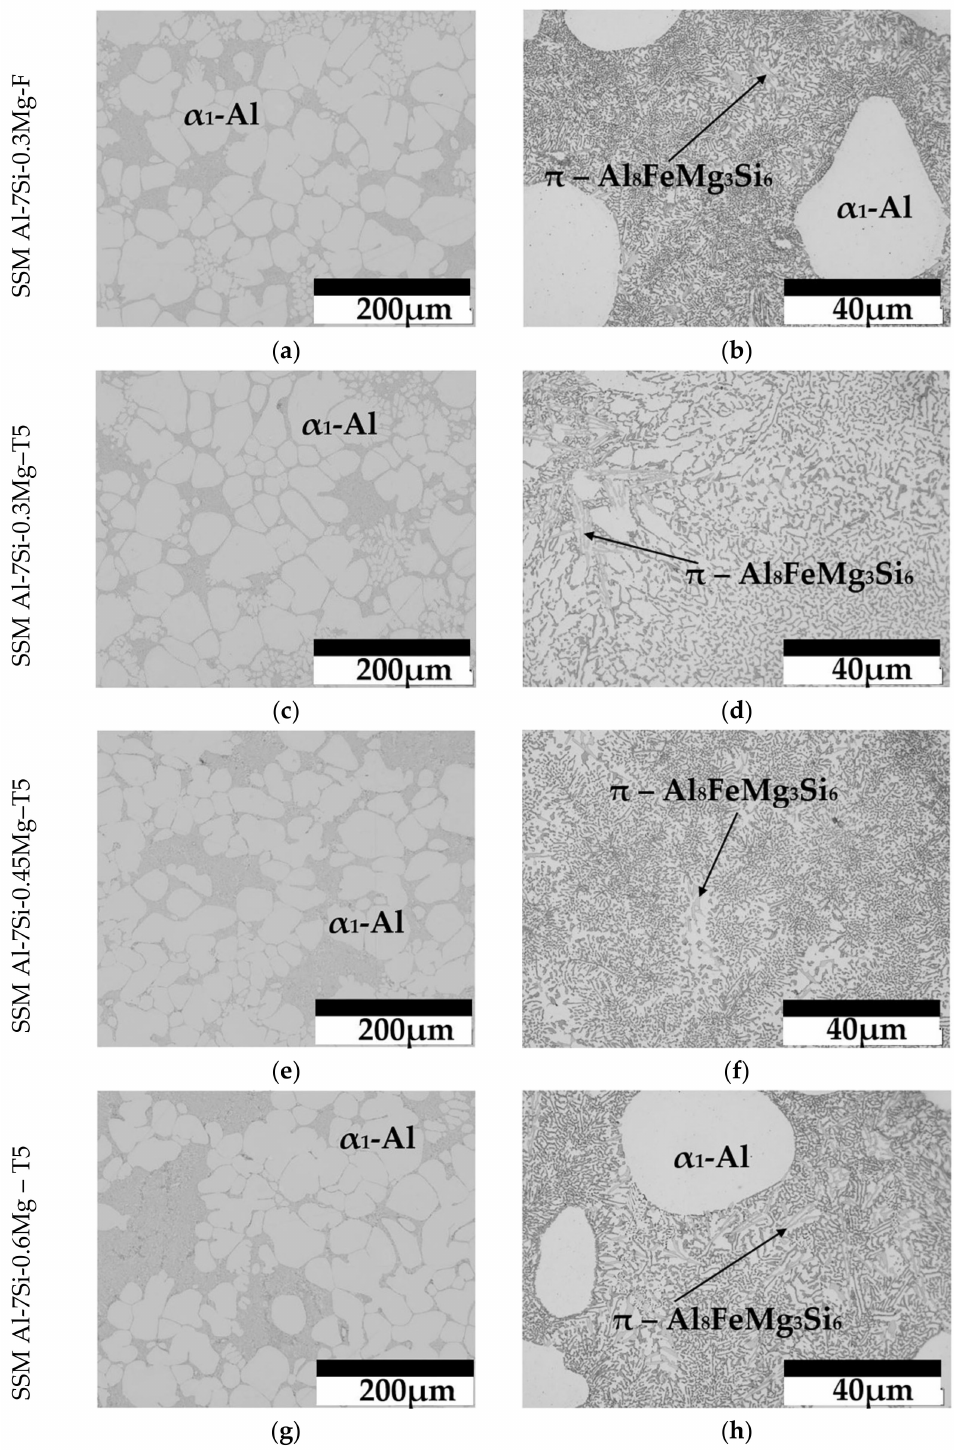
Figure 7. Micrographs of the di ff erent Semi-Solid Metal (SSM) castings; ( a , b ) SSM Al-7Si-0.3Mg–F, ( c , d ) SSM Al-7Si-0.3Mg–T5, ( e , f ) SSM Al-7Si-0.45Mg–T5, ( g , h ) SSM Al-7Si-0.6Mg–T5. Light grey: iron-rich intermetallics. Dark grey: eutectic